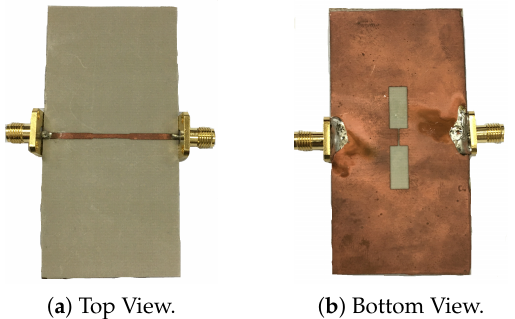
Figure 9. Photographs of the fabricated one-pole Butterworth low-pass filter designed at 3 GHz with the DGS section under the transmission line of the length 2 ∗ l 2 for the approximation of the physical dimensions a, b and g of the DGS